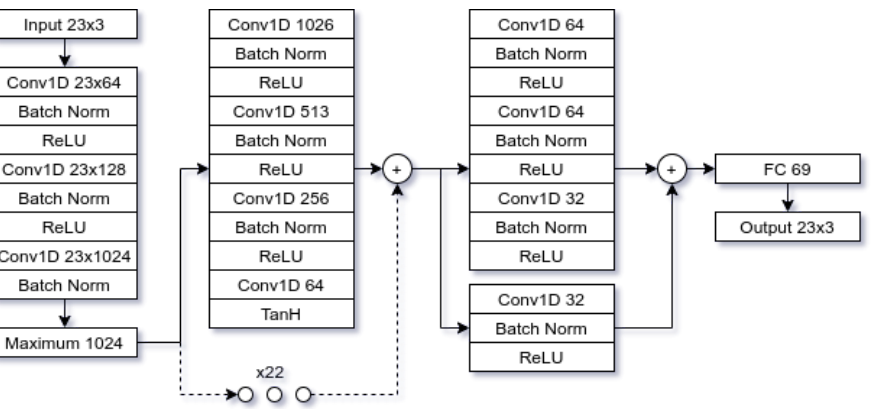
Figure 3. Inverse kinematics of a skeleton, resulting output is Euler